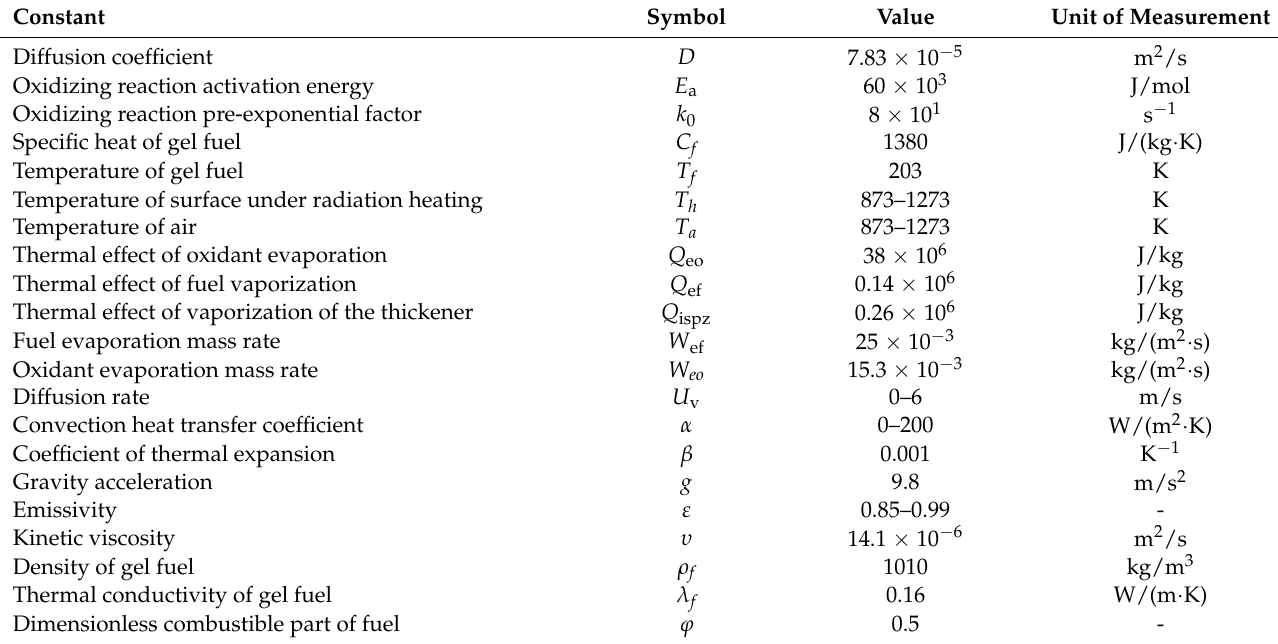
Table 1. Data for the numerical simulation